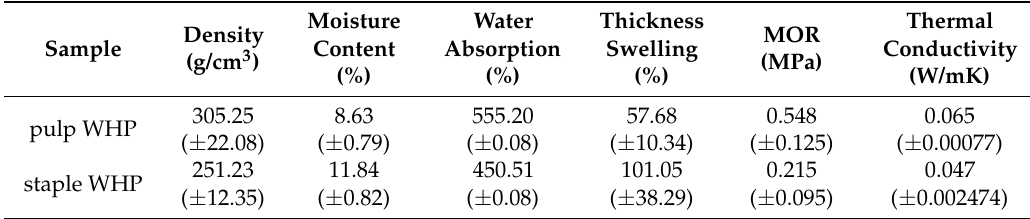
Table 3. WHP boards